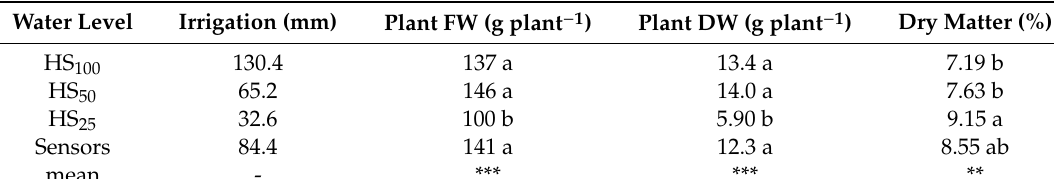
Table 3. Experiment 1: Fresh and dry matter yield and dry matter percentage as a ff ected by the irrigation strategy in lettuce. Di ff erent letters indicate significant di ff erences in the Tukey HSD test ( p ≤ 0.05). Data are the means of three replicates. Significance codes: *, significant at p ≤ 0.05; **, significant at